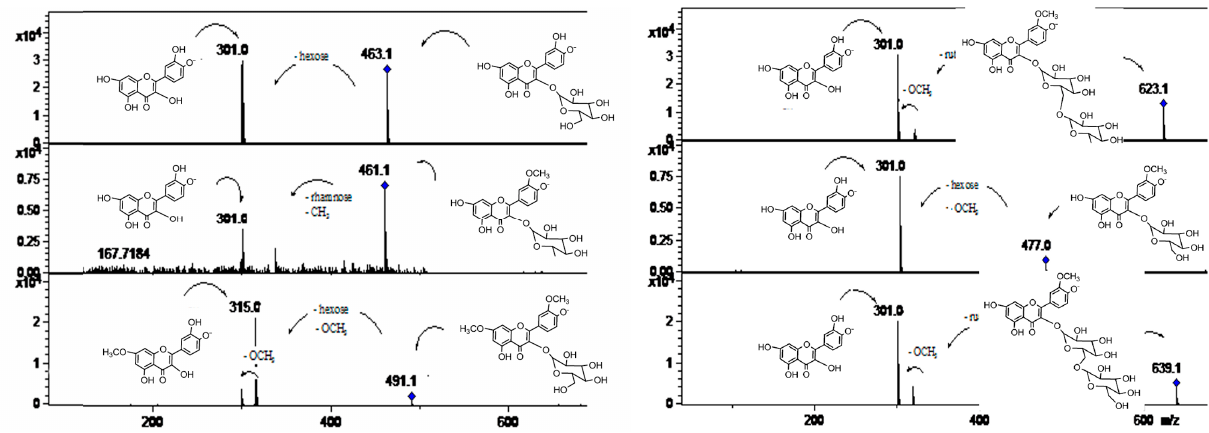
Figure 6. MS spectra of peaks 5 , 23 , 24 , 26 , 29 and 32 . (Refer to Table